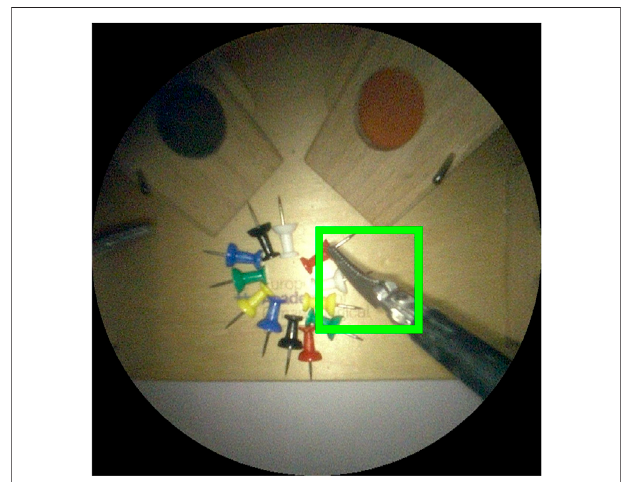
FIGURE 13 | Image crop of visible area of 1080p endoscope video frame. The green square is the 200 × 200 pixel bounding box used to evaluate detection performance. An intersection over union ≥ 50% between predicted and ground truth bounding boxes is considered a correct